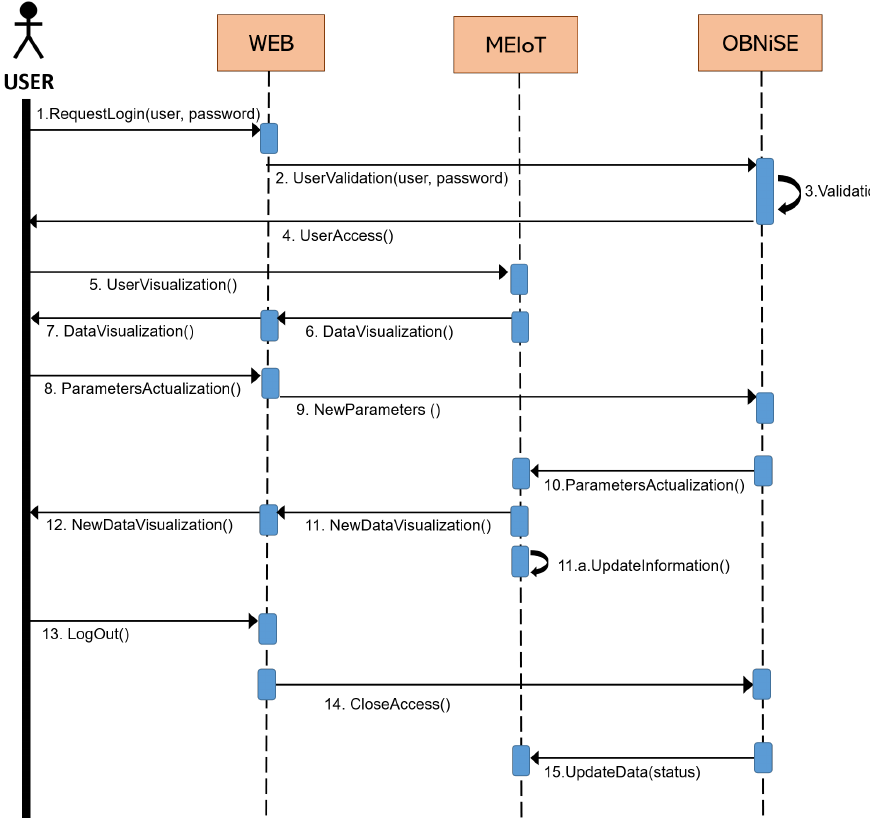
Figure 12. Sequential diagram connection between the user and the system. The pedagogical activities for the three levels with the selected perspective, which are concrete learning level, graphic learning level, and abstract learning level, are defined as follows. First, the educator turns on the MEIoT weather station with exogenous disturbance input to go through the session, and all the participants log in to the web